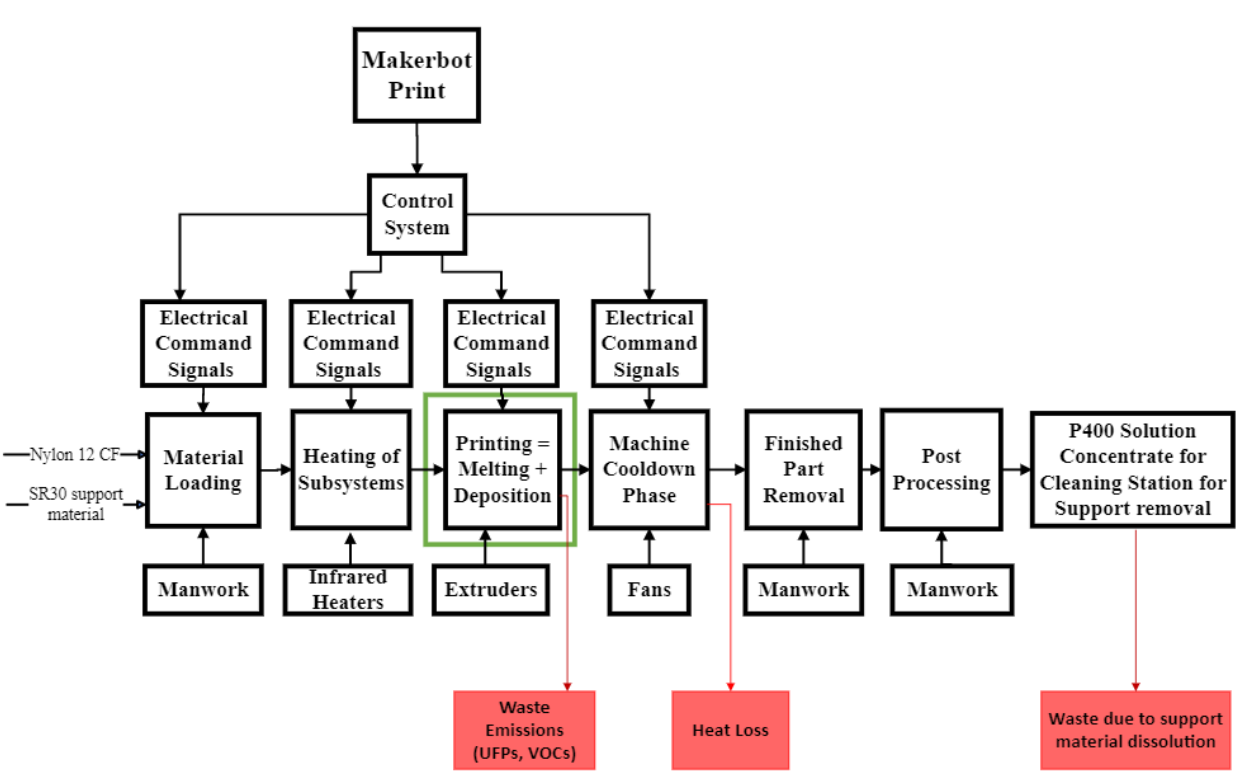
Figure 2. Functional decomposition of the fused deposition modeling process .